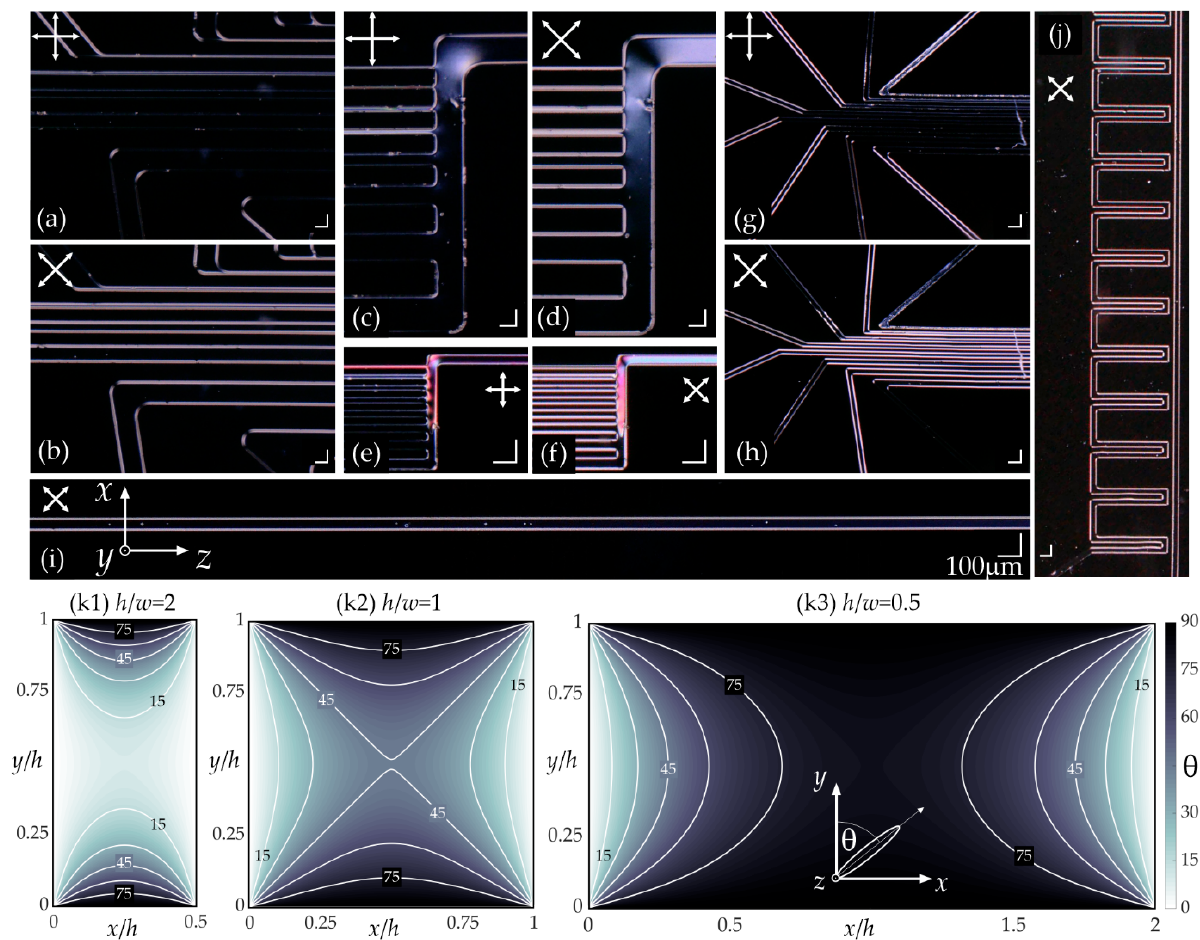
Figure 6. ( a – h ) The PDMS:glass-based sets of test microchannels of different widths infiltrated with 5CB NLC and observed under the polarizing microscope. Details related to channel dimensions are given in the text. ( i , j ) POM images of the 50- µ m-wide channels of different geometries obtained in the PDMS:PDMS architecture using the SU-8 mold. The scale bars are 100 µ m in all of the photographs. ( k1 – k3 ) Results of the numerical simulations showing the LC molecular arrangement (determined by the orientation angle θ in the x – y plane) in the microchannels’ cross-sections with different aspect ratios ( h / w ).